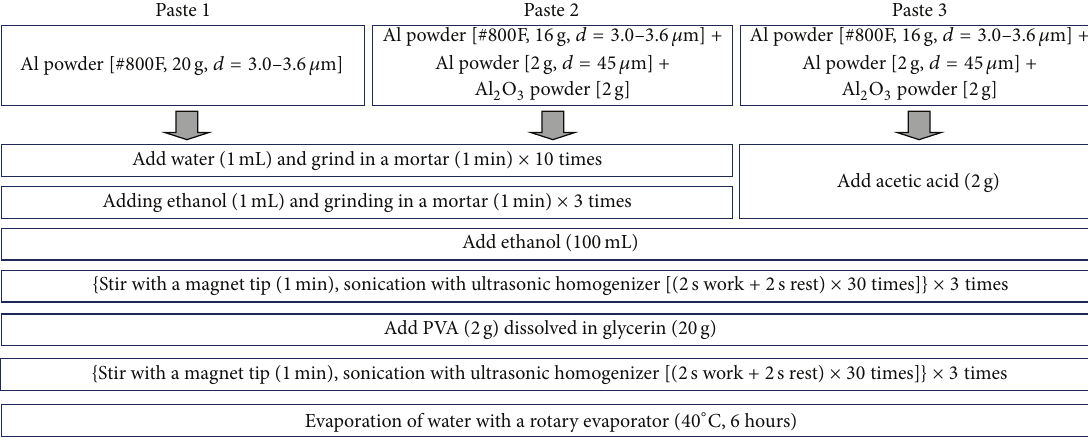
Figure 1: Flow chart of polyvinyl alcohol-based aluminum paste production.